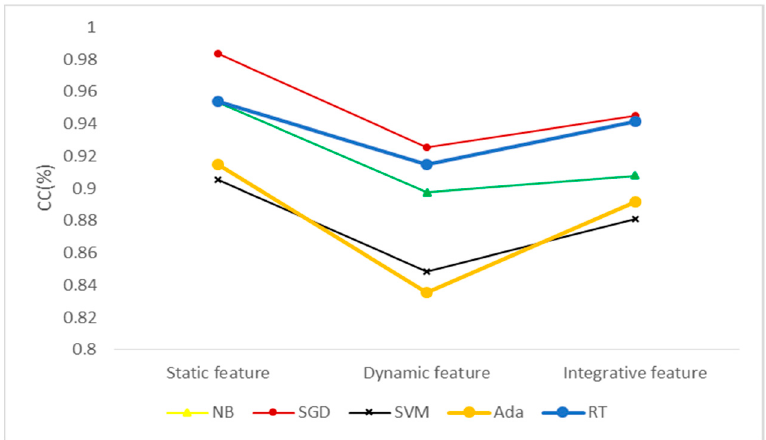
Figure 6. Classification effect of different algorithms under different types of features. CC (Correctly Classified rate, CC), NB (Naive Bayes, NB), SGD (Stochastic Gradient Descent, SGD), SVM (Support Vector Machine, SVM), Ada (Adaboost, Ada) and RT (Random Trees, RT).